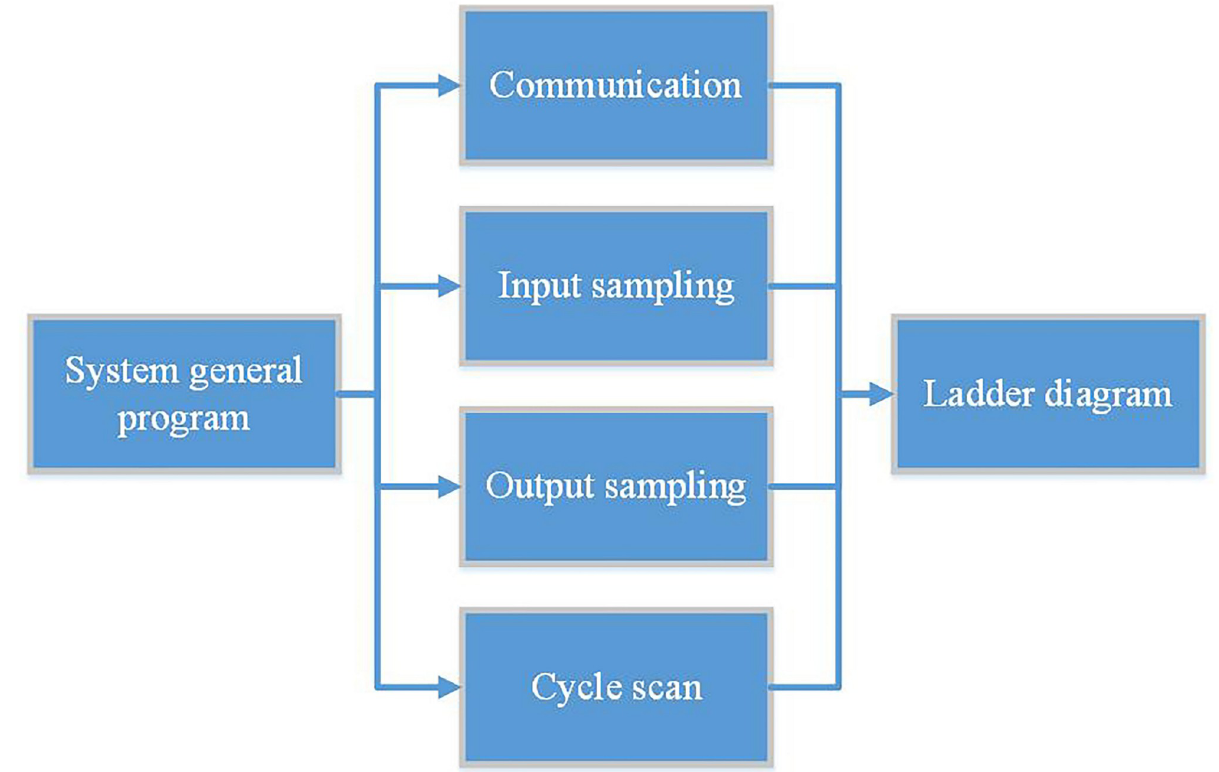
Fig 4. Software structure diagram of embedded soft PLC control system for rapier loom.